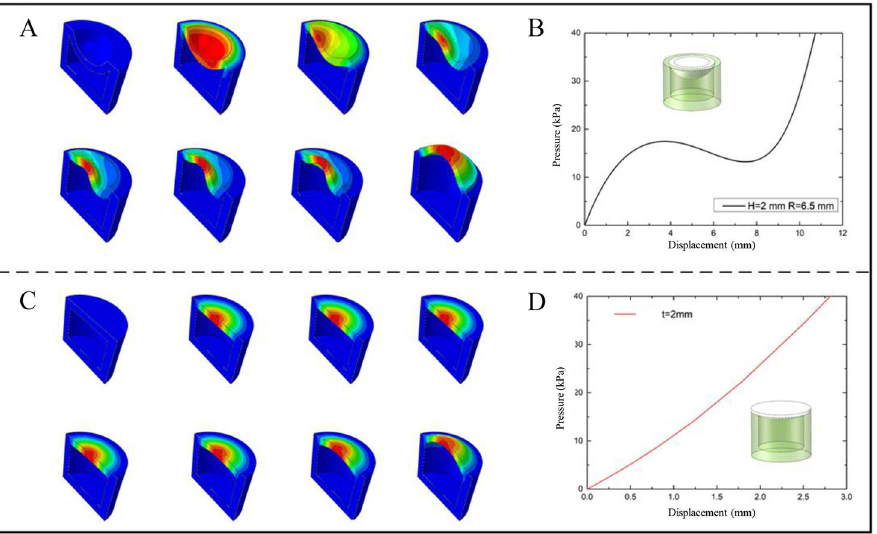
Figure 3. ( A ) The deformation cloud diagram of spherical crown membrane, ( B ) The load displace- ment curve of spherical crown membrane, ( C ) The deformation cloud diagram of flat membrane, ( D ) The load displacement curve of flat membrane.